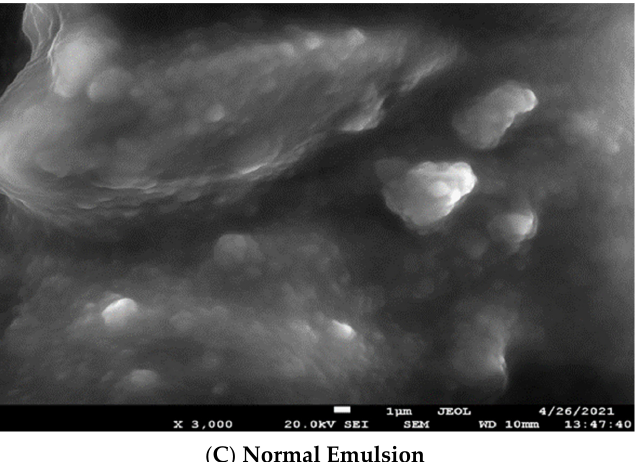
Figure 7. Photo study experienced samples prepared using scanning electron microscopy (total magnification of ×5000) Cheese matrix: ( A ) Control, ( B ) CUNE ( C ) Normal emulsion.